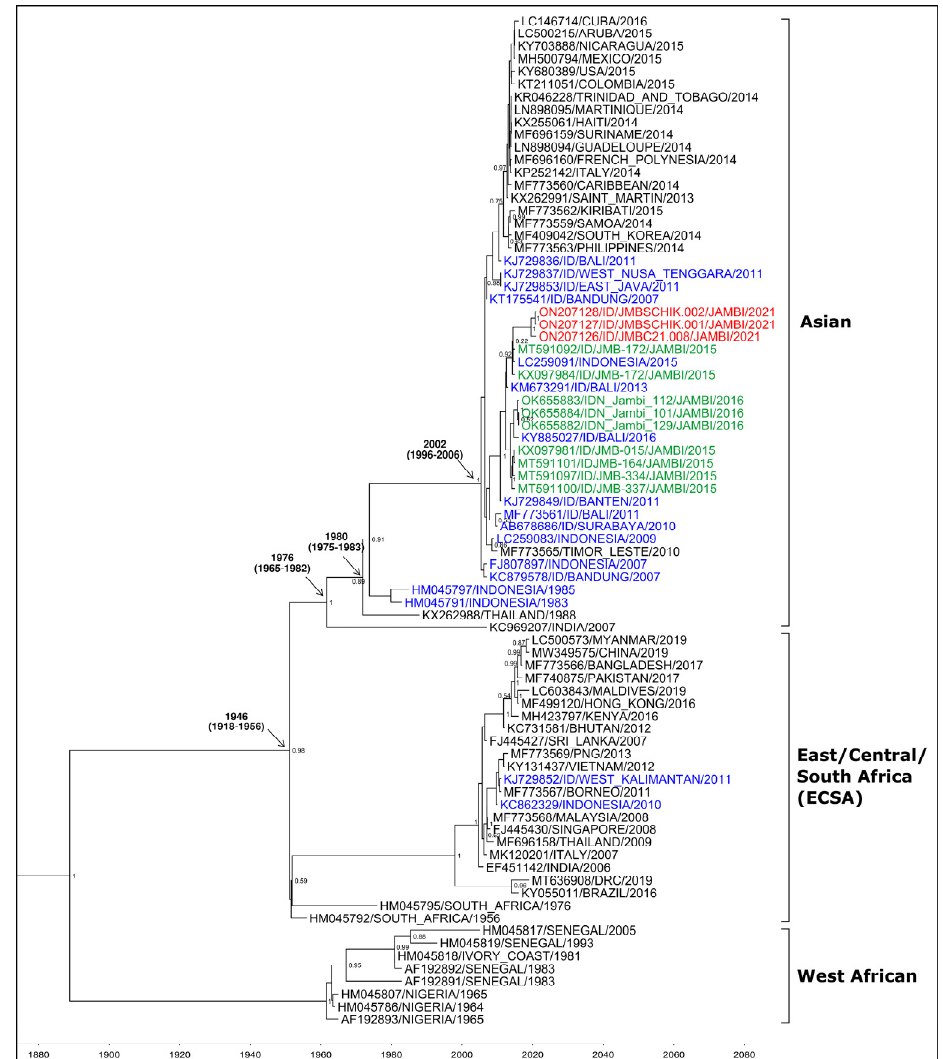
Figure 1. Phylogenetic analysis of CHIKV isolates from Jambi 2021 (red); Jambi 2015 and 2016 (green); other cities in Indonesia (blue); and other countries (black), grouped into genotypes.